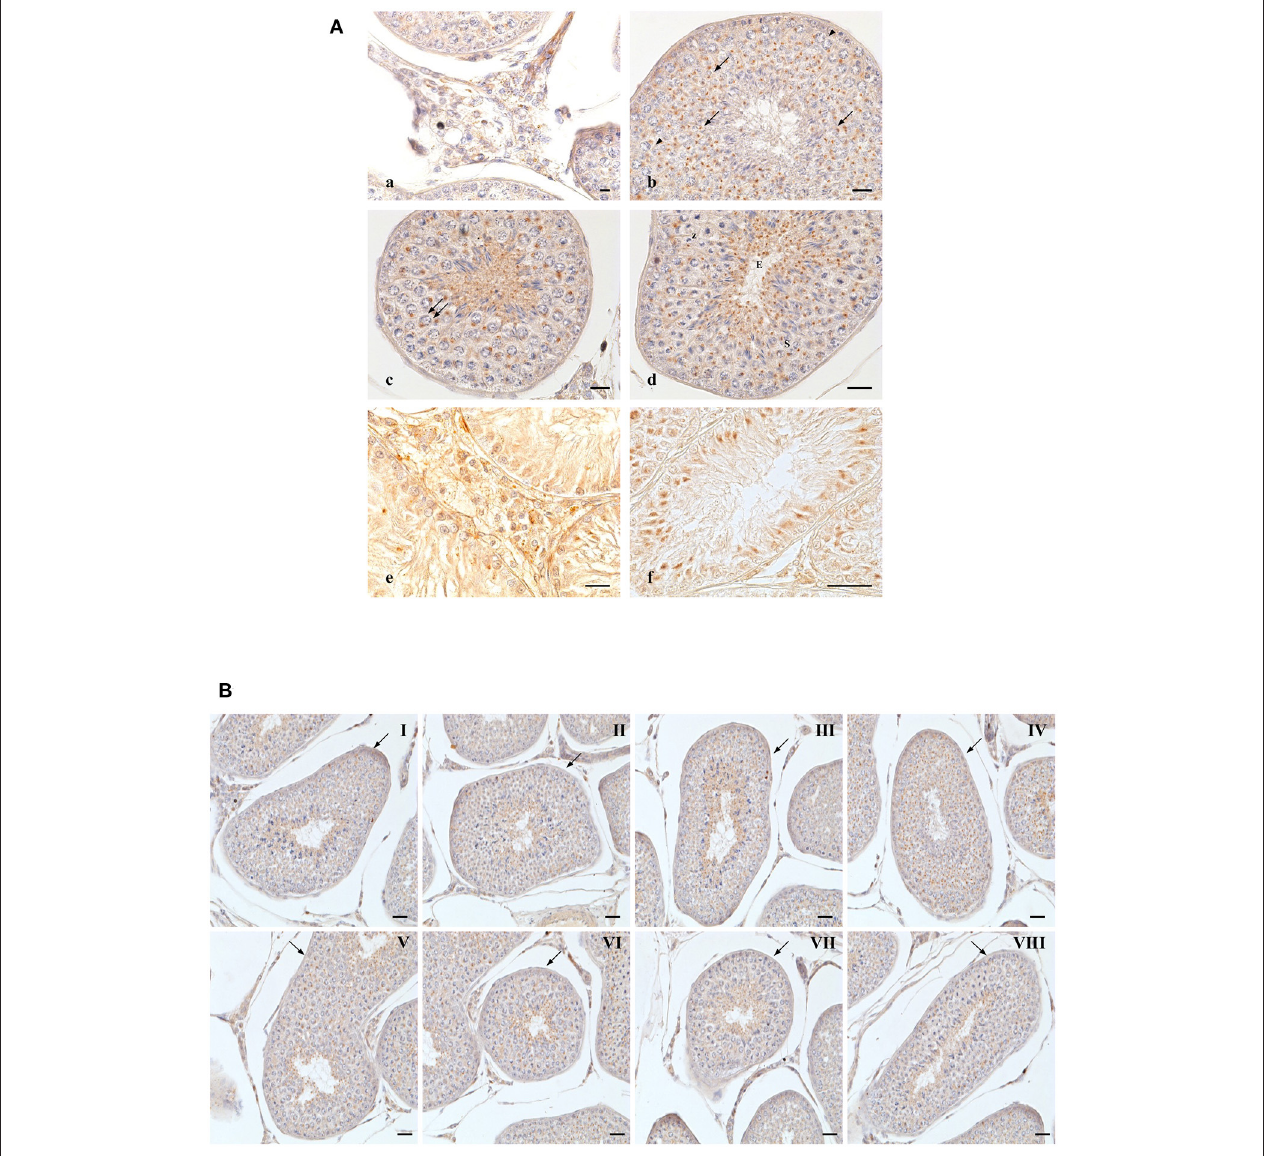
FIGURE 2 | OX2R-IR in normal and cryptorchid canine testis. (A) Group of Leydig cells labeled with micro-granular material through the entire cytoplasm (a); deeply stained single round granular structure located in perinuclear area of pachytene (b, arrowheads), diplotene (c, double arrow), zygotene (d,Z). Relatively smaller compact punctiform materials are observed in secondary spermatocytes (d,S); round (b, arrows) and elongated (d,E). In cryptorchid dog testes. Leydig cells are stained with finer granular substances diffused through the entire cytoplasm (e); intensive immunoreactions are observed the Sertoli cells, particularly in basal and apical regions (f). Bars: 20 µ m. (B) OX2R-IR in normal dog testes along the entire germ developing cycle. Bars: 30 µ